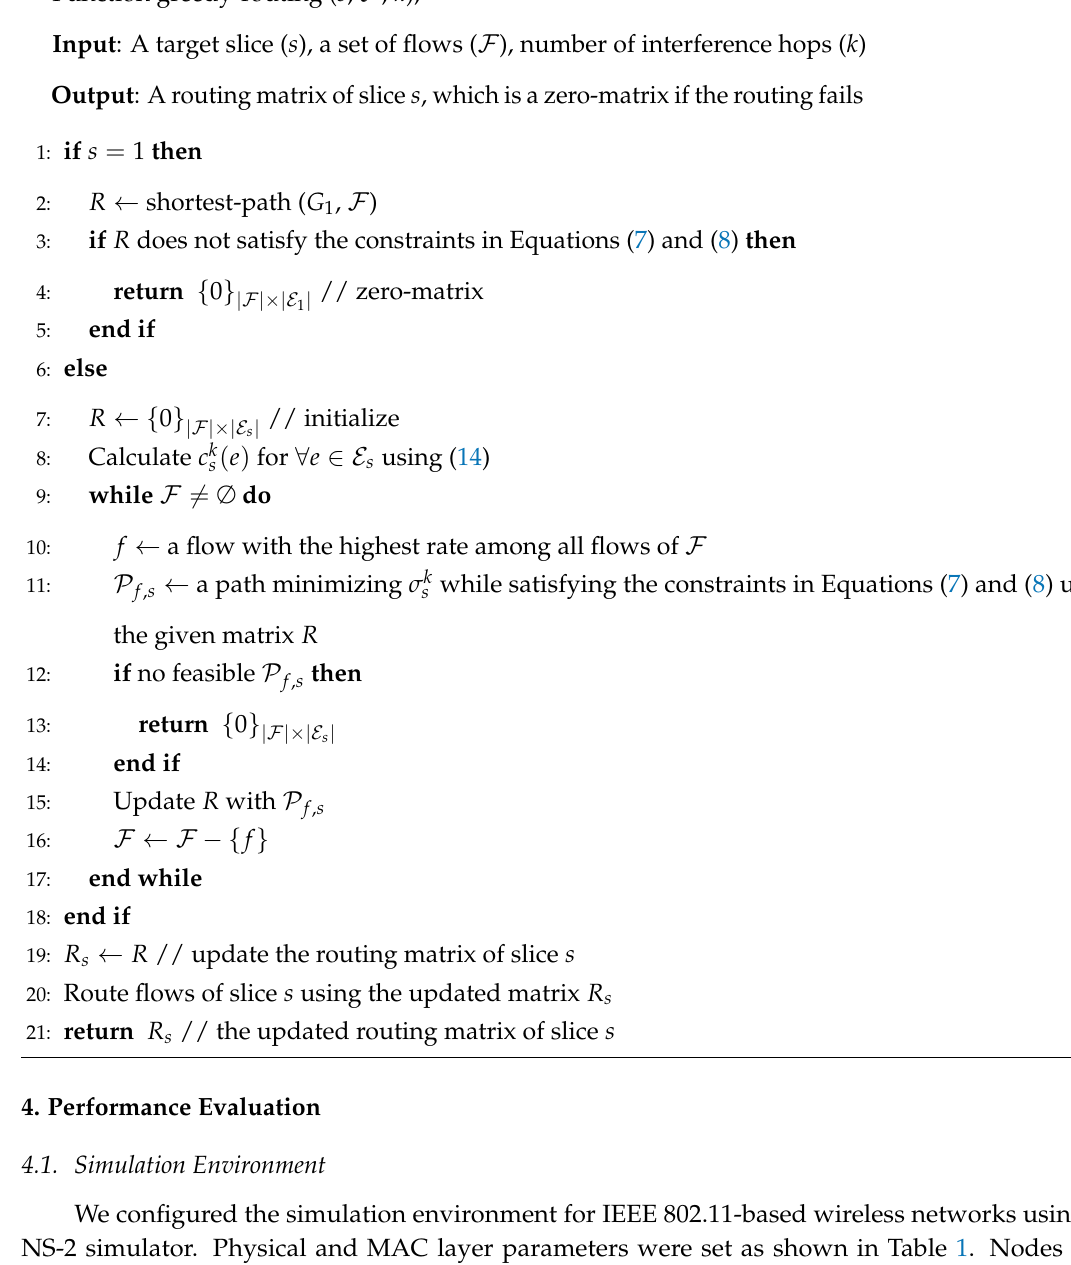
Algorithm 1 k -hop greedy